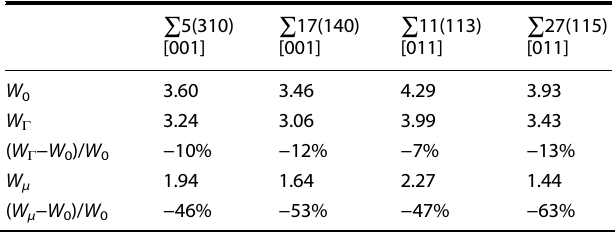
Table 5. Work of separation for (a) pure GBs, W 0 , (b) fast fracture at constant H concentration, W Γ , and (c) slow fracture at constant chemical potential, W μ (unit: J/m 2 ) Fig. 4 H adsorption energy vs. local electron density at different